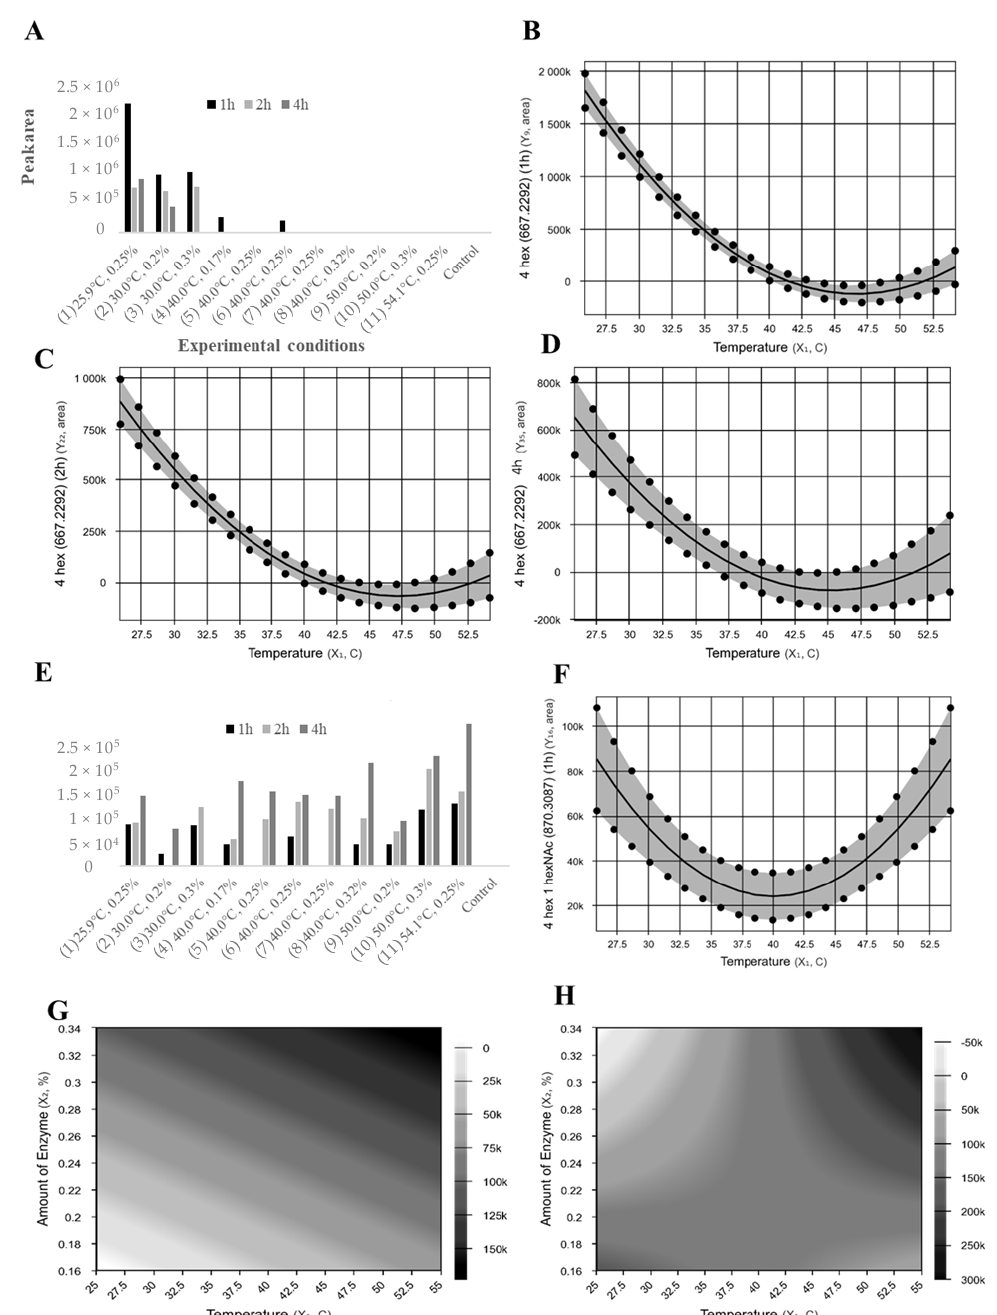
Figure 3. Peak areas of extracted ion chromatograms from nano-LC Q-ToF MS analysis and contour curve for the abundance of the formed neutral oligosaccharides. ( A – D ), 4 Hexose (Hex) (667.2292) (1 h, 2 h, and 4 h, respectively); ( E – H ), 4 Hex 1 Hex with either N-Acetyl-Glucosamine or N-Acetyl-Galactosamine (NAc) (870.3087) (1 h, 2 h, and 4 h, respectively).